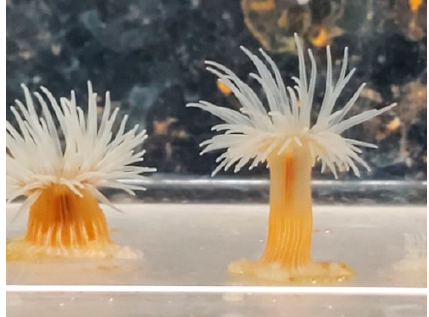
Figure 1. Photo of the sea anemone Aiptasiomorpha minuta (pedal disk diameter = 5 to 7 mm) grown under laboratory conditions fed with Artemia salina .